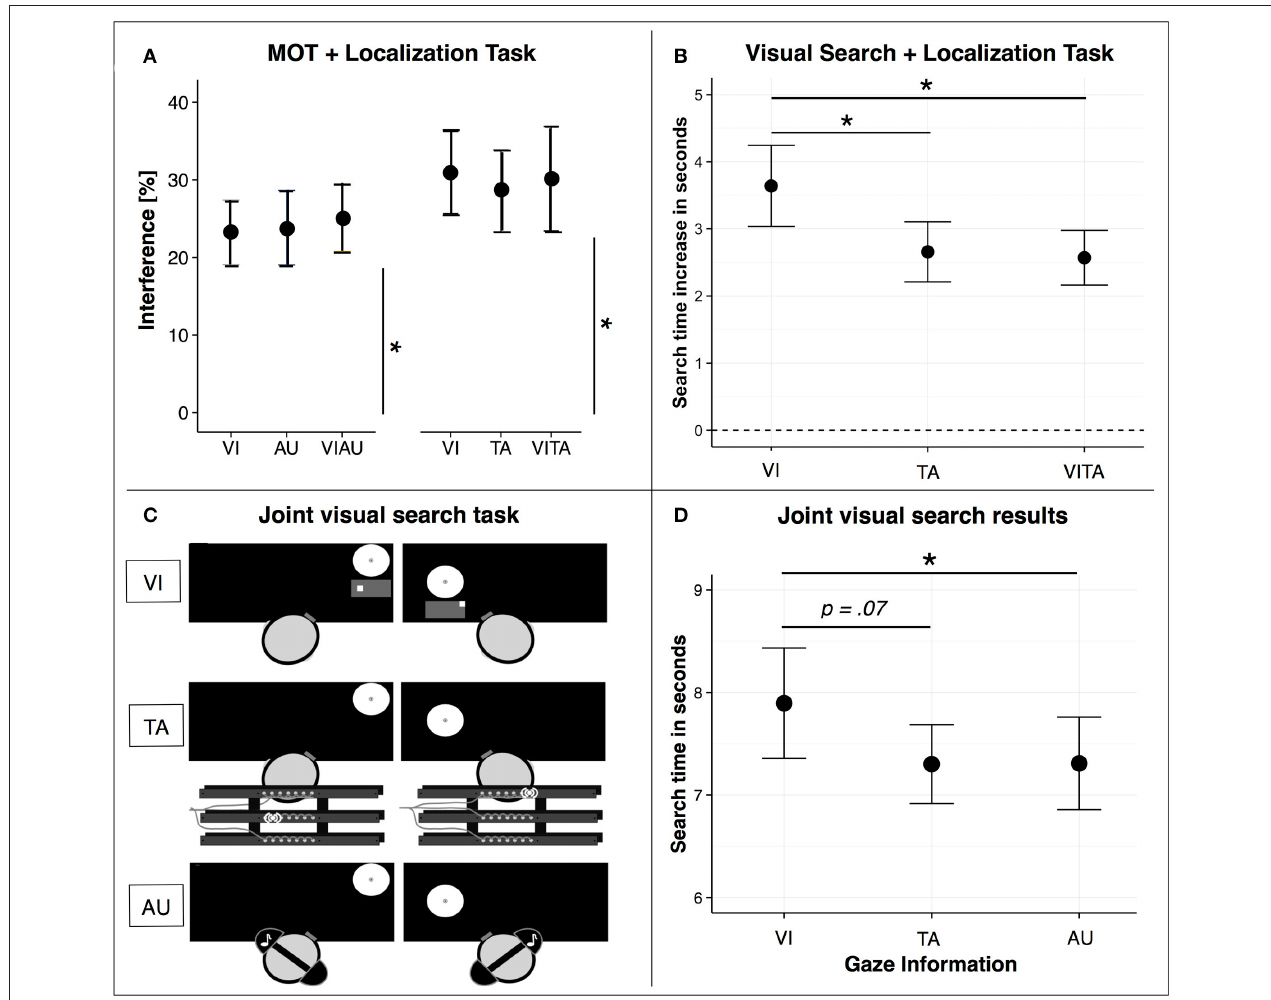
FIGURE 2 | (A) Dual task interference when participants perform the MOT task either in combination with a visual (VI), tactile (TA), audiovisual (VIAU), or visuotactile (VITA) localization task. Interference is measured as the reduction in performance between single and dual task conditions. In particular, the reduction in performance for both tasks (i.e., MOT and localization task) are combined by taking the Euclidean distance between the performances in the single and dual task conditions, separately for each combination of tasks (MOT + VI, MOT + AU, MOT + TA, MOT + VIAU, MOT + VITA). (B) Search time increase relative to performing the visual search task alone when participants perform the same task either in combination with the VI, TA, or VITA localization task. (C) Joint visual search task conditions. Co-actors jointly searched for a target among distractors on two separate computer screens. A black mask was applied to the whole screen and only the currently viewed location was visible to the co-actors. Co-actors received the information about where their co-actor was looking either via a visual map (VI) that was displayed below their viewed location, via vibrations on a vibrotactile belt (TA), or via tones received through headphones (AU). (D) Joint visual search results. Search performance (i.e., time of the co-actor who found the target first) as a function of the sensory modality (VI, TA, or AU) in which the gaze information was received. Error bars in (A,B,D) are standard error of the mean. *Indicate significant comparisons with an alpha of .05. (A) has been adapted from Wahn and König (2015a,b), (B) from Wahn and König (2016), and (C,D) from Wahn et al.